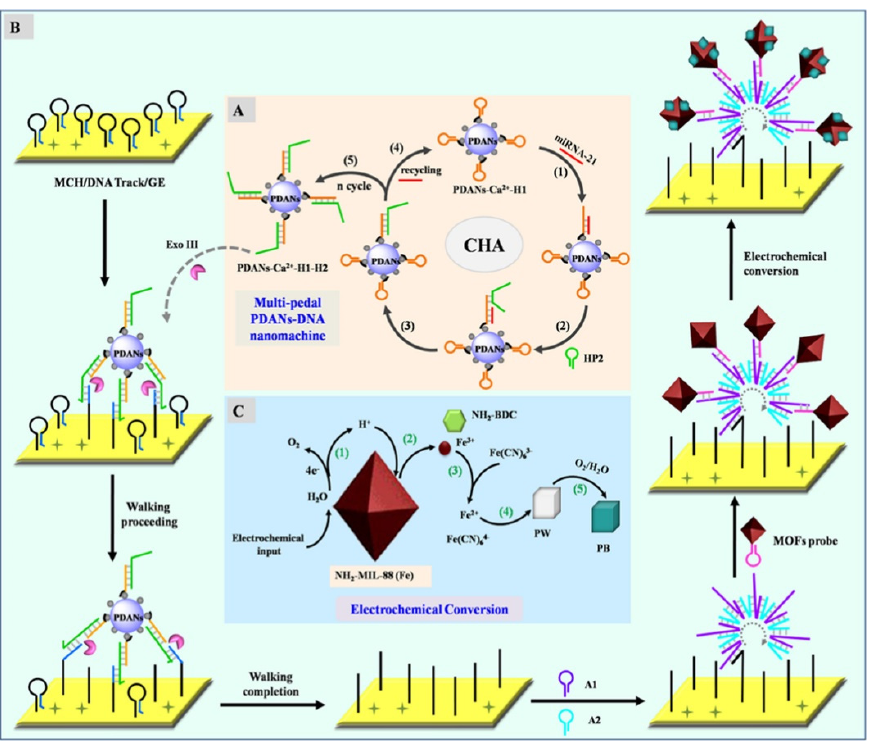
Figure 15. Schematic illustration of the biosensor of miRNA-21 based on PDANs − DNA nanomachine and the electrochemical conversion of MOFs. Reprinted with permission from Ref. [261]. Copyright 2021, American Chemical Society.